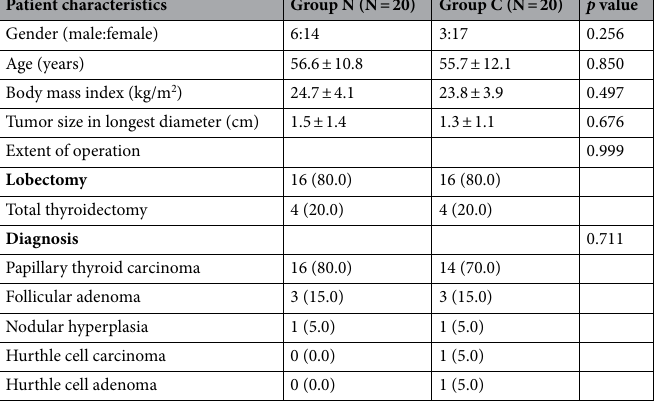
Table 1. Patient characteristics. All data are presented as mean ± standard deviation or as n (%), unless stated otherwise.